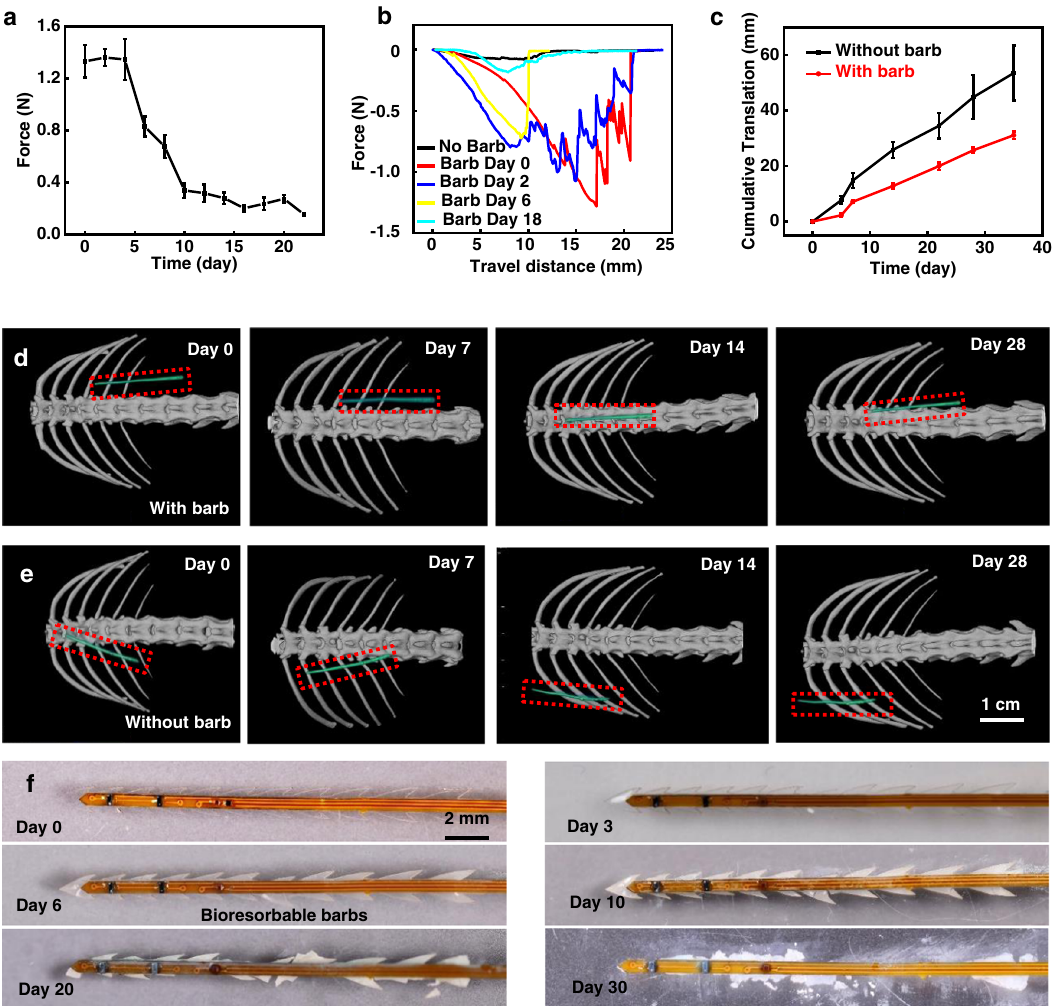
Fig. 3 Characterization of NIRS probes with bioresorbable barbs. a Measured maximum pulling force to remove a probe inserted in a tissue phantom for different times of immersion in phosphate buffered saline (PBS) solution at 37 °C. n = 3 independent samples. All data are shown as mean ± SEM. b Representative pulling force as a function of removal distance for probes with and without barbs. c Cumulative translation distance of NIRS probes with and without barbs implanted in vivo. The measurement relies on quantitative analysis of Computed Tomography (CT) images of NIRS probes implanted subcutaneously in mice. n = 3 independent samples. All data are shown as mean ± SEM. d , e CT images showing the location of implanted NIRS probes with or without barbs respectively. All images share the same scale bar. f Images showing the process of bioresorption of barbs during soaking tests in PBS at 37 °C. Source data are provided as a Source Data fi